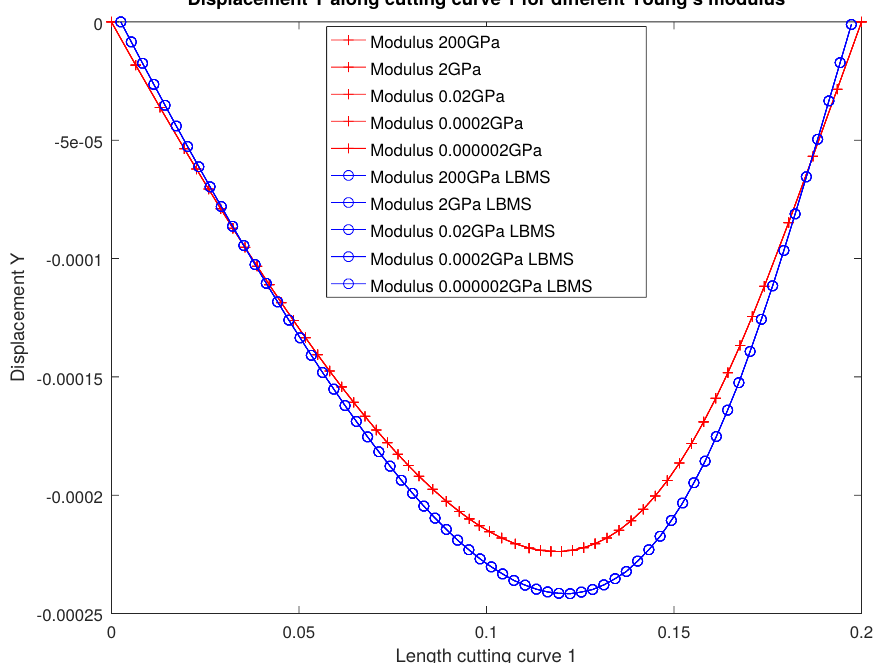
Figure A17. Second displacement components along cutting curve C 1 for different Young’s modulus.